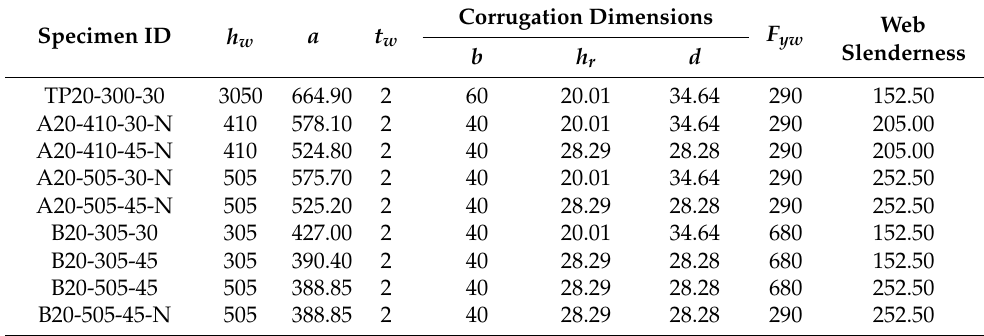
Table A8. Data of specimens tested by Moussa et al. [29].